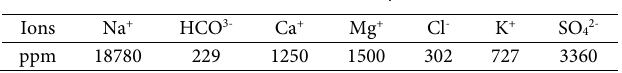
Table 2. Sea water analysis Table 3: Sea water analysis